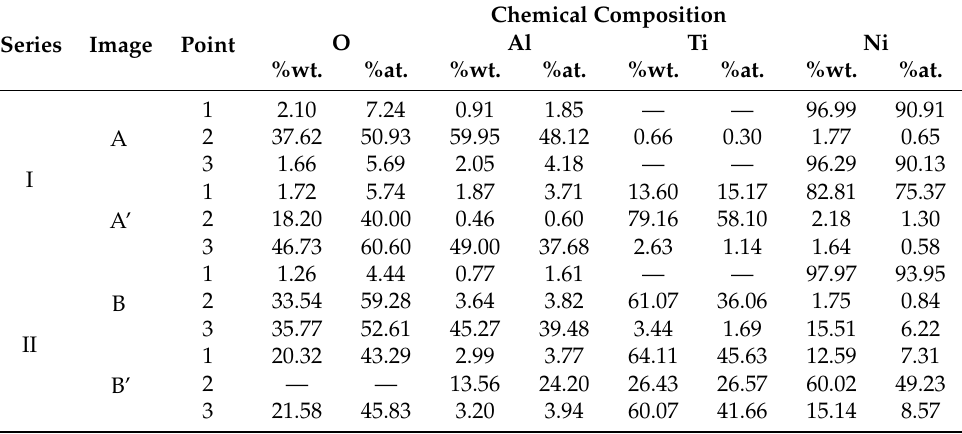
Table 4. Chemical composition of characteristic areas of the composites. Measurement areas are shown in Figure